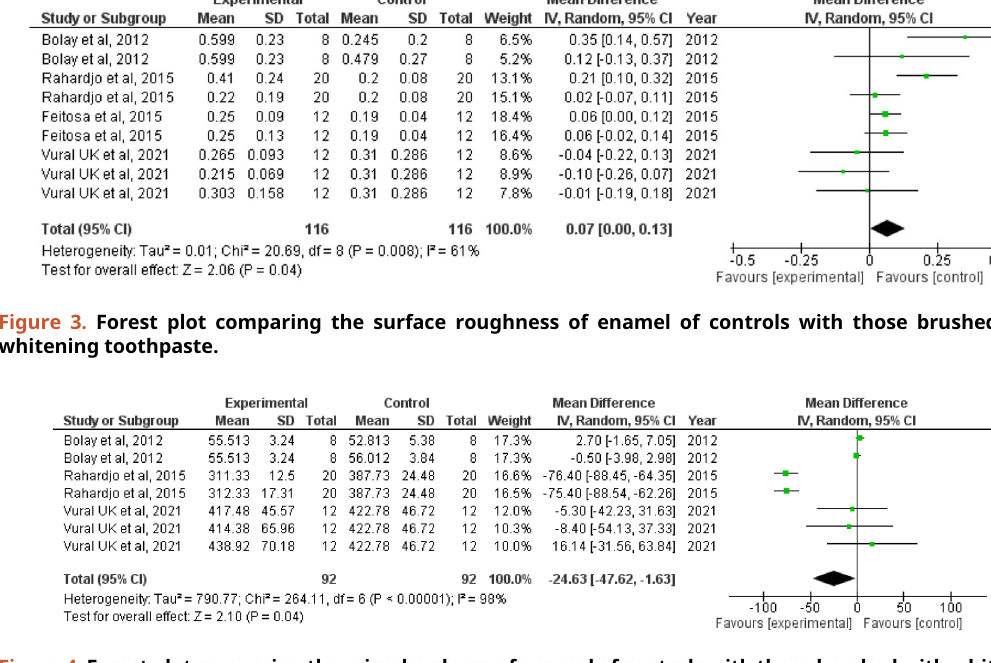
Figure 4. Forest plot comparing the microhardness of enamel of controls with those brushed with whitening toothpaste.